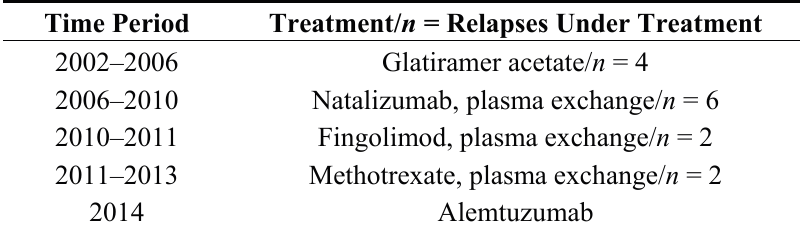
Table 1. History of MS treatment and disease activity in case